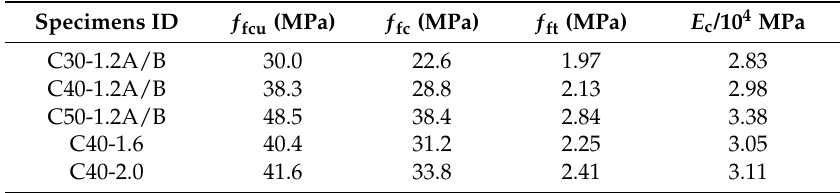
Table 4. The tested basic mechanical properties of the steel fiber-reinforced concrete with recycled aggregates